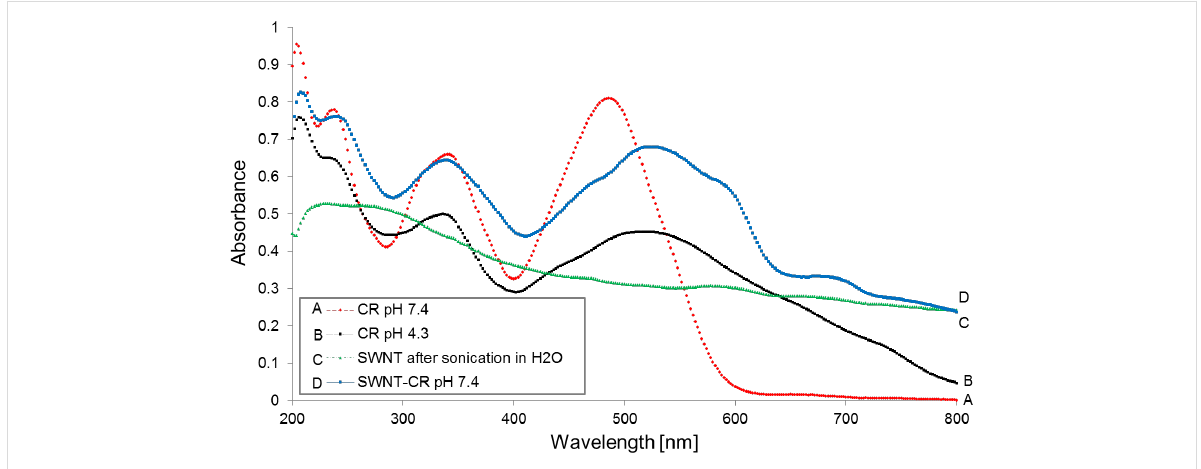
Figure 1: Absorption spectra of free Congo red (A) and SWNT-bound Congo red (D) (0.05 M Tris/HCl buffer, pH 7.4); Congo red spectrum after acidi- fication to pH 4.3 (B); free SWNT suspension spectrum (C).